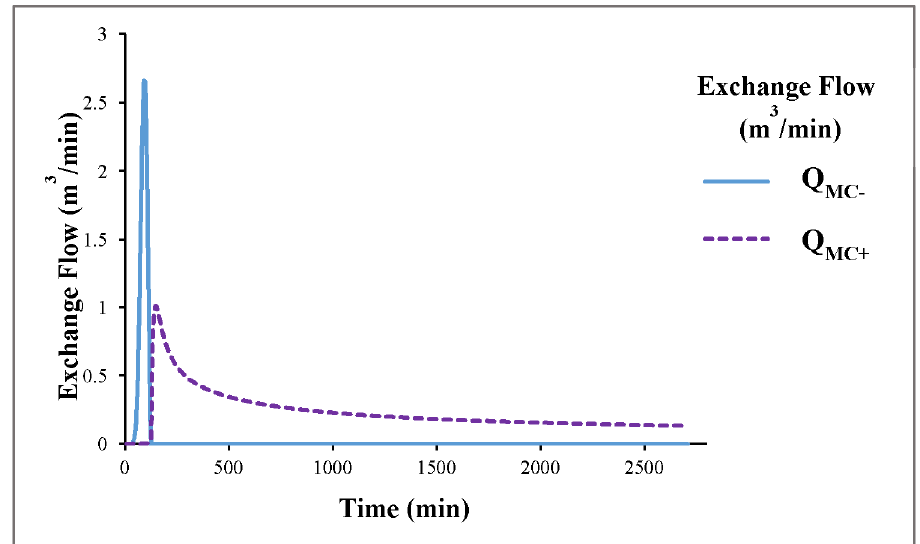
Figure 5. Temporal changes of the direction of the exchange flow. The Q MC− discharge dominates only in part of the CFR time during rainfall in the karst aquifer and then the Q MC+ discharge dominates in a situation with the exchange coefficient of 10 −3 m 2 /s and conduit diameter of 0.5 m.